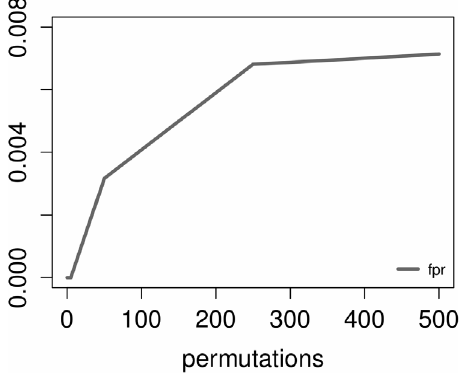
Figure 2. False positive rate vs. number of permutations.